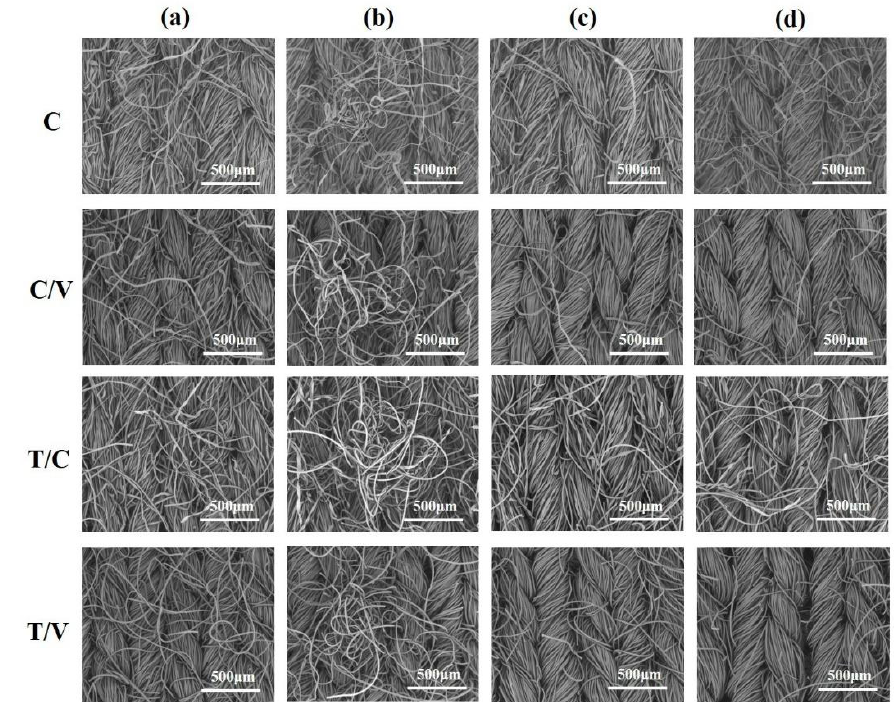
Figure 9. SEM images of original and treated fabrics before and after 2000 pilling cycles. ( a ) original fabrics; ( b ) original fabrics after pilling; ( c ) treated fabrics with the dipping process; ( d ) treated fabrics with the dipping process after pilling.